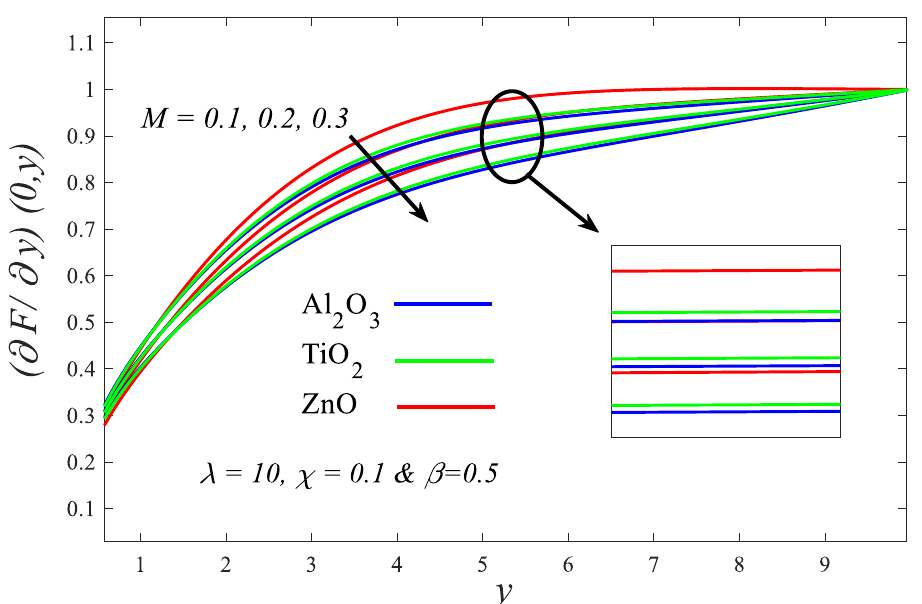
Figure 17. Impression of M on ∂ F / ∂ y . The inset is a partial enlargement of the